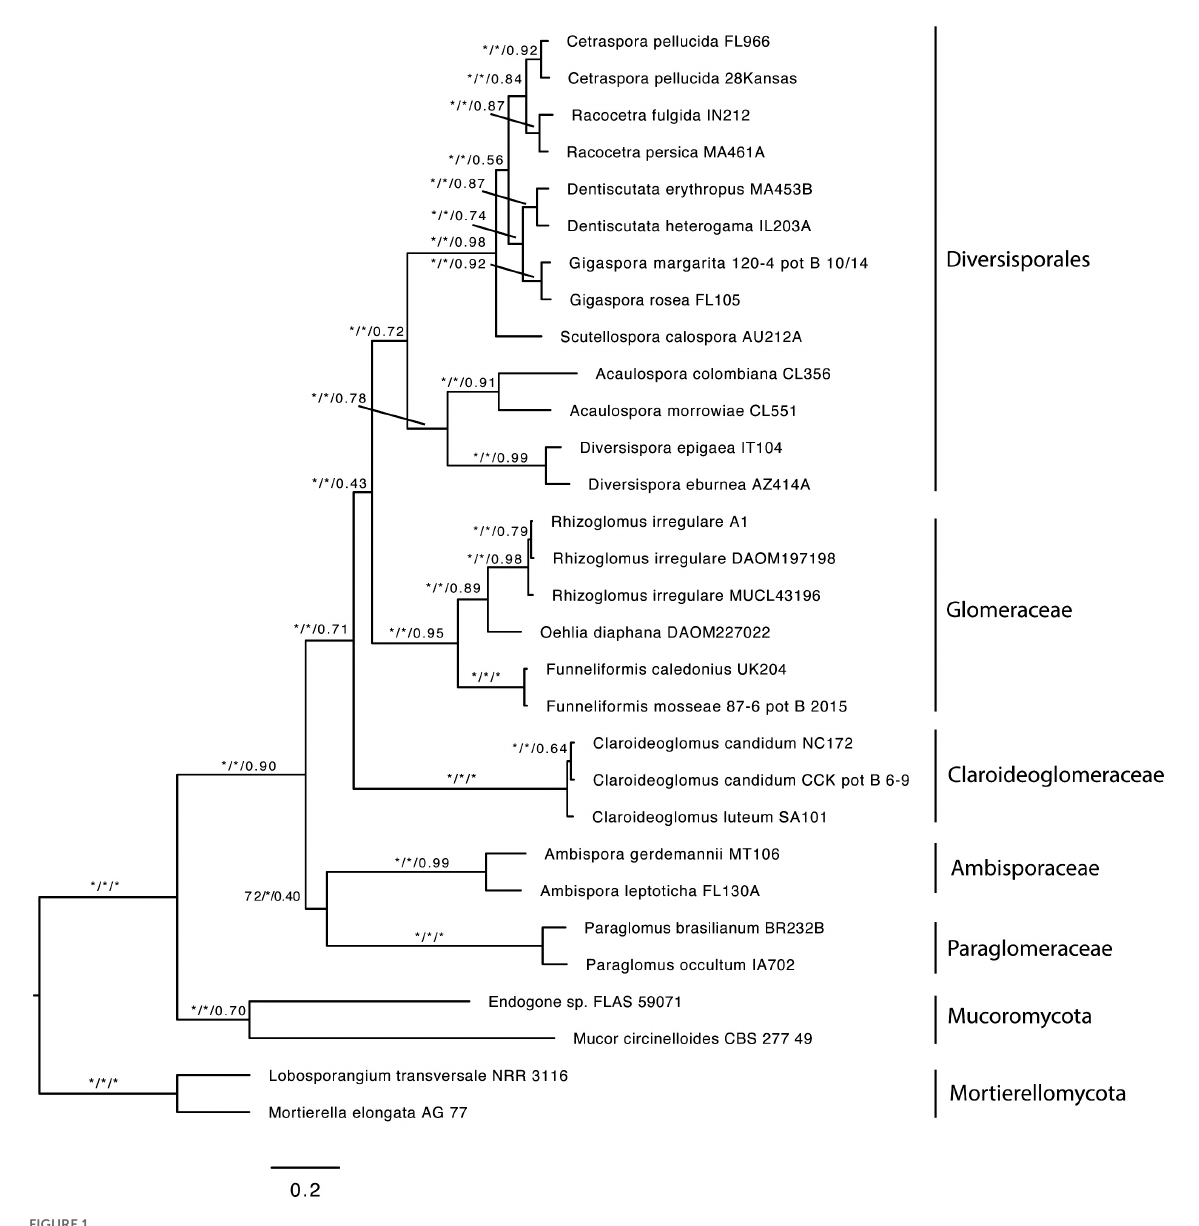
FIGURE1 Best Maximum Likelihood phylogeny inferred with IQ-TREE from a concatenated alignment of 1260 single copy orthologs shared by at least 50% of the taxa. The same topology was recovered with ASTRAL III. Values near the branches correspond to bootstrap support (BS) from the ML analysis, local posterior probabilities (LPP), and quartet support from the ASTRAL analysis (BS/LPP/quartet support). Asterisks indicate maximum support (100 or 1.0). Mucoromycota and Mortierellomycota were used as outgroups. Bar indicates 0.2 expected change per site per